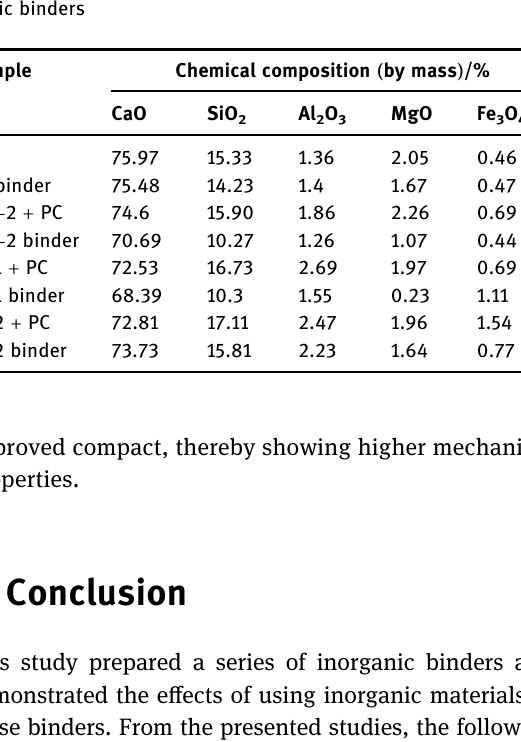
Table 4: Chemical composition of mixed raw materials and inor - ganic binders